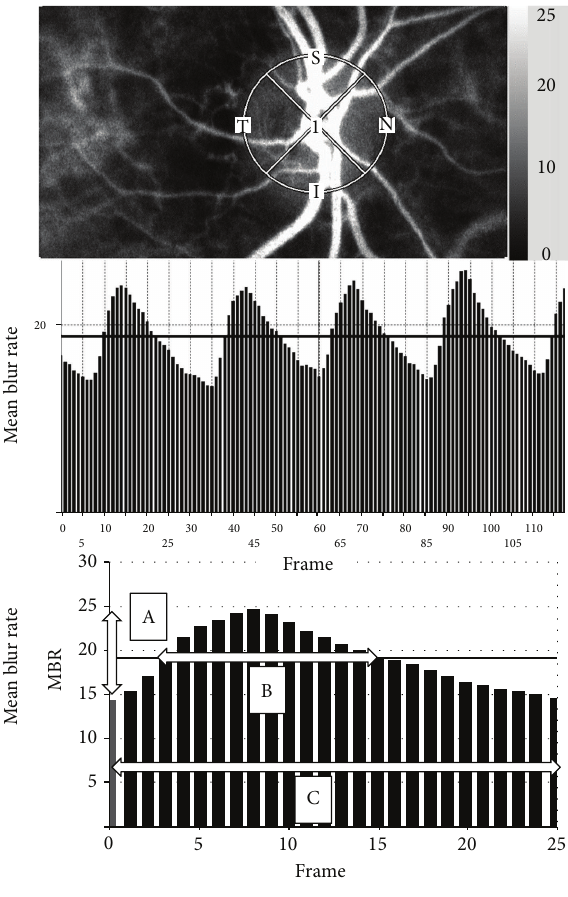
Figure 1: Method of determining the pulse-wave velocity in the optic nerve head circulation by laser speckle flowgraphy (LSFG). Upper panel: a gray scale photograph of the fundus of the eye. the circle designates the area that was measured in the optic disc area. Middle panel: pulse waves showing changes in the MBR which is tuned to cardiac cycle for 4 seconds. The total number of frames is 118. Lower panel: normalization of one pulse. A = maximum MBR– minimum MBR. B = number of frames spent at one-half the value of A. C = number of frames spent at normalized one